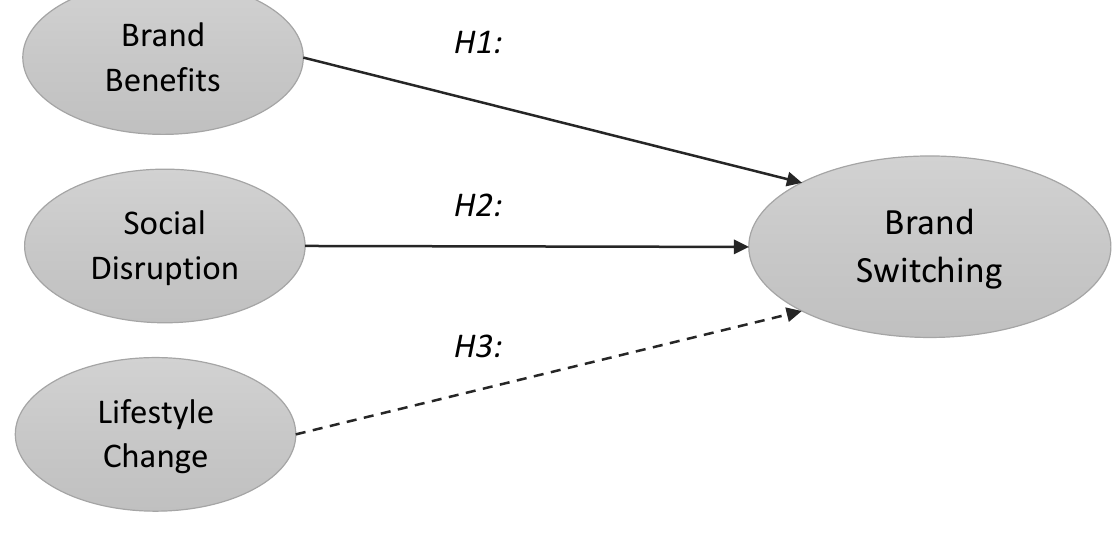
Figure 1. Hypothesized